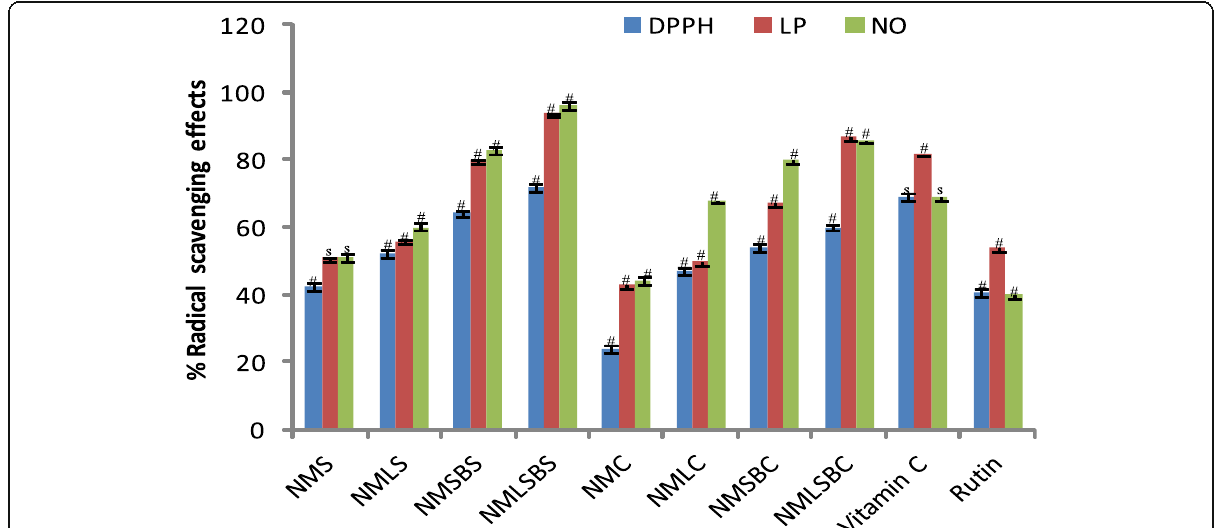
Fig. 3 Radical scavenging effects of neem cosmetics with and without secondary metabolites and reference compounds at 0.50mg/mL (#=significantly different, s=not significantly different p